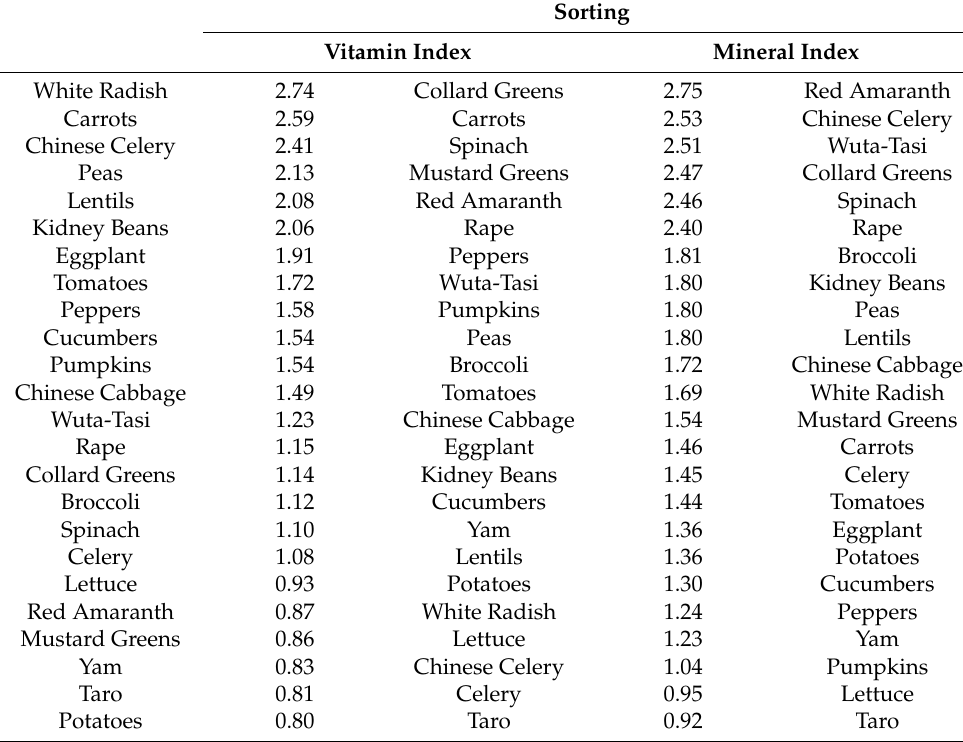
Table 4. The Vitamin Index and Mineral Index Results of the